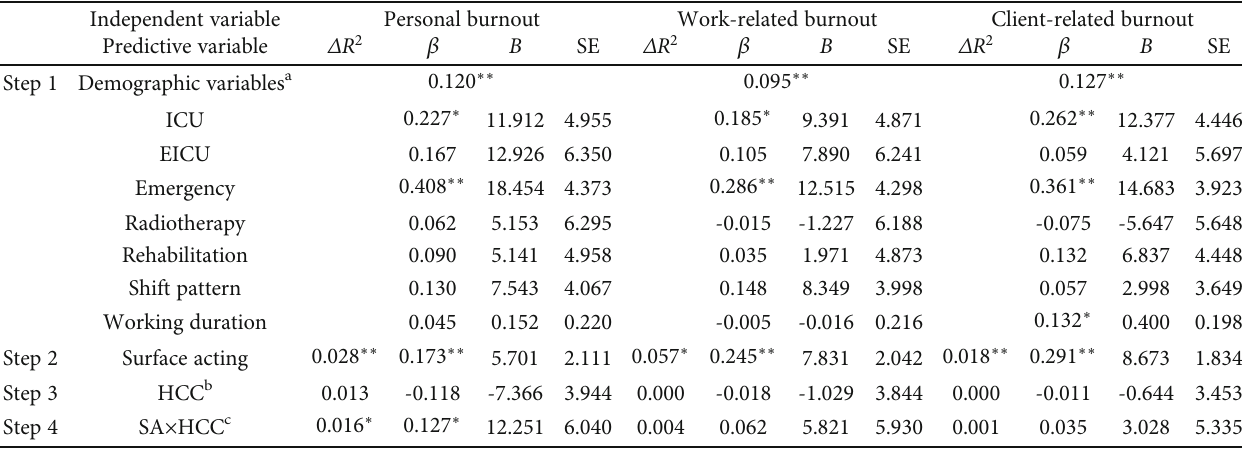
Table 3: Coe ffi cients of multiple linear regression of surface acting, hair cortisol content, and their interaction against Copenhagen job burnout ( n = 229